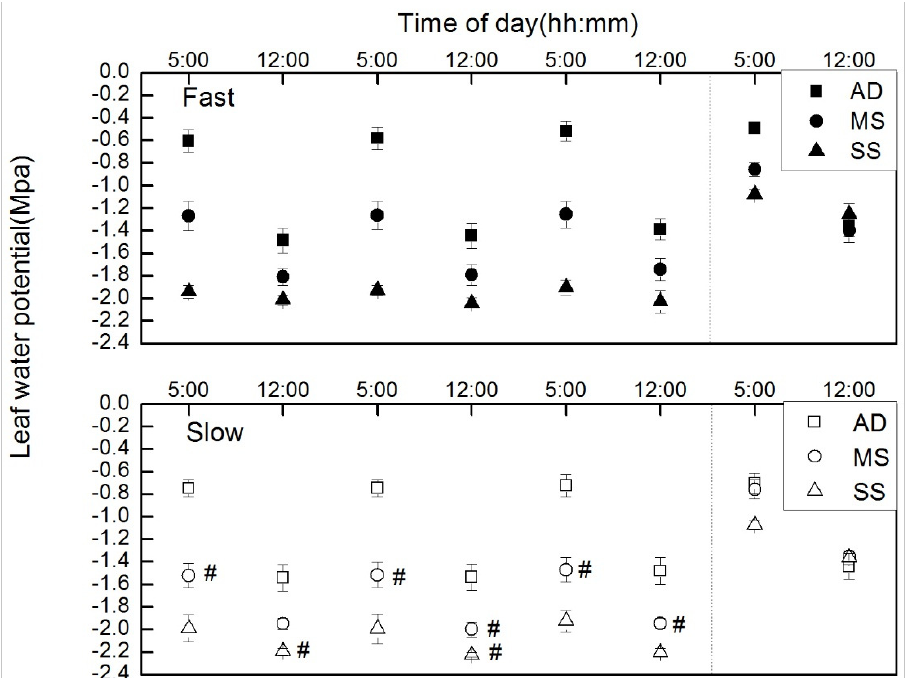
Figure 1. The ψ values of both fast (filled symbol) and slow (empty symbol) genotypes (I-101 ( Populus alba L . ) × 84K ( Populus alba L . × Populus glandulosa Uyeki)) were measured for AD plants, MS plants and SS plants (AD represents control group, MS represents moderately water-stressed, and SS represents severely water-stressed; square for AD plants, circle for MS plants, and triangle for SS plants) at 10, 20 and 30 days after drought treatment (from left to right) and at 15 days (right (behind the dashed line)) after the rewater. The ψ pred values were recorded at 05:00, and the ψ midd values were recorded at 12:00. The dashed line denotes the time of watering. Each datapoint represents the mean value (±SE) for six plants. # Indicates data that are significantly different between fast- and slow-growing genotypes under the same treatment.